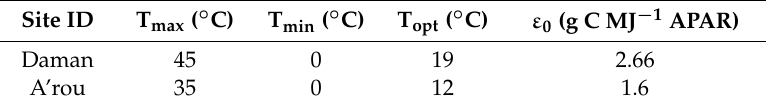
Table 1. Parameters of the VPM at the Daman and A’rou